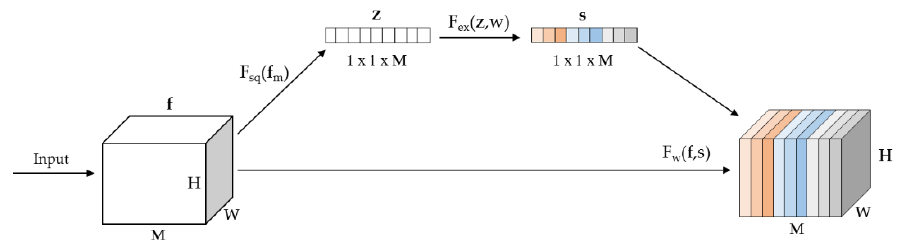
Figure 4. The structure of the Squeeze-and-Excitation module. Fsq(fm) is the process of global average pooling. Fex(z,w) is the step to obtain different weights for every channel of feature maps, and Fw(f,s) can combine the input and weights to produce the final output of this module (revised after